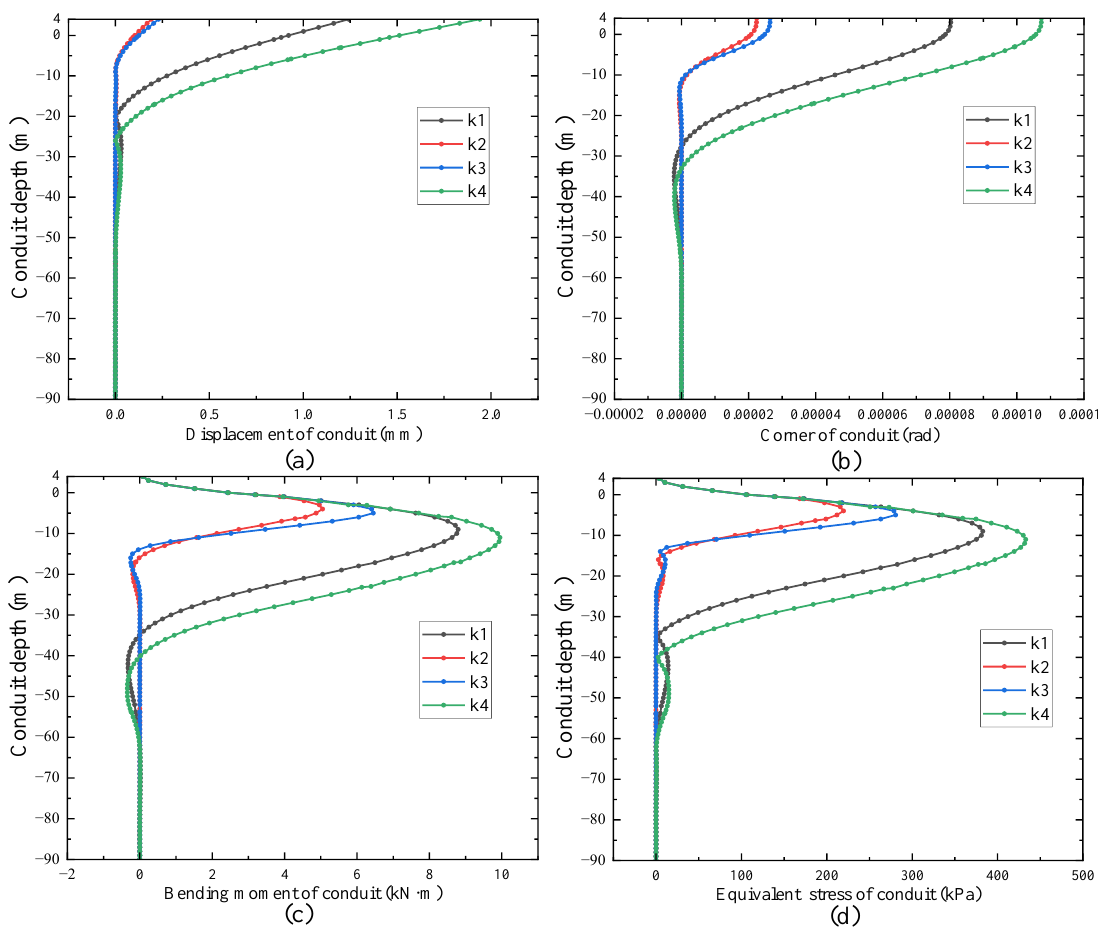
Figure 5. ( a ) Effect of seabed soil properties on conductor displacement, ( b ) Effect of seabed soil properties on conductor turning angle, ( c ) Effect of seabed soil properties on conductor bending moment, ( d ) Effect of seabed soil properties on conductor equivalent force.